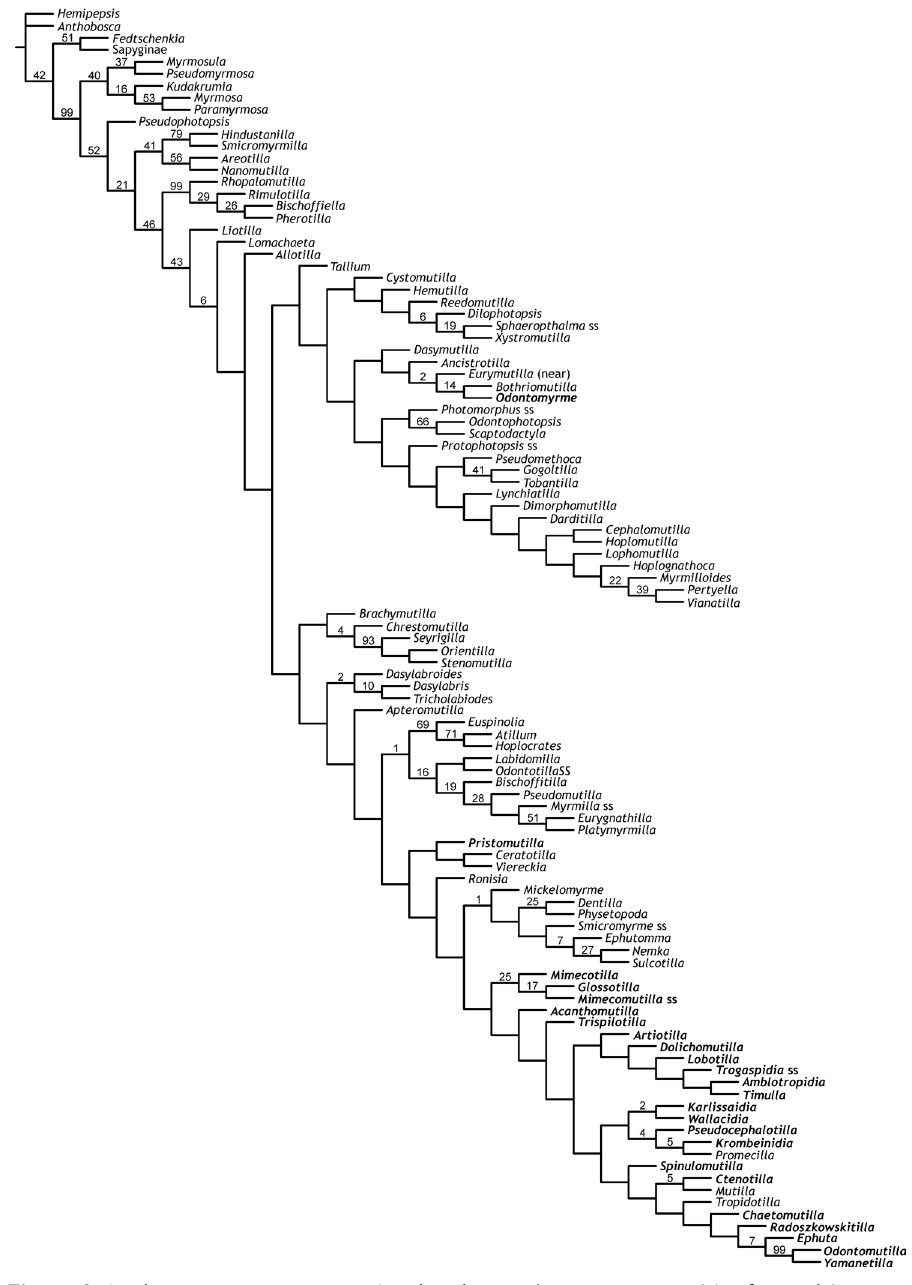
Figure 9. Single most-parsimonious tree (raw length = 1134, ci = 0.19, ri = 0.61), of 101 sub/genera of Mutillidae and 4 outgroups, females only, 97 characters many additive and all with implied weighting (N = 5, k = 81). Group support (GC) values shown for all groups supported by resampling. Terminals in bold are those whose placements differ by more than mere taxonomic level in the classifications of DB and LN (see Appendix